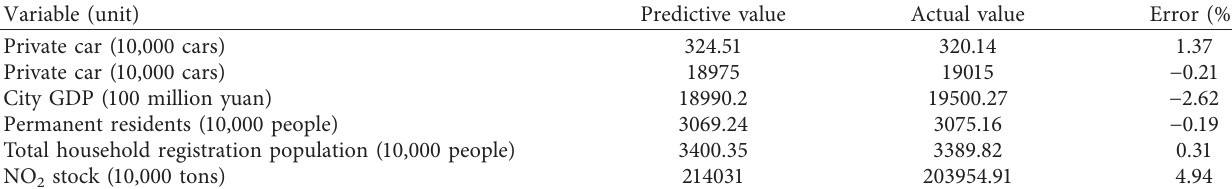
Table 4: Comparison of model simulation predictions with real values (2017).